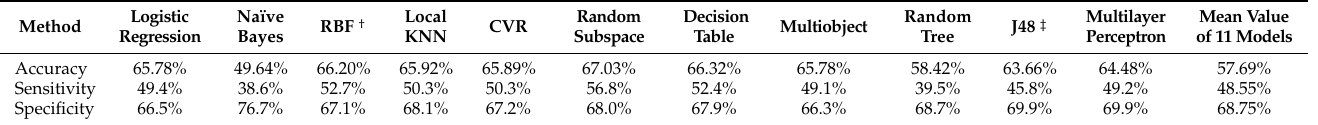
Table 3. Evaluations of accuracy, sensitivity, and specificity of 11 prediction models of obesity.